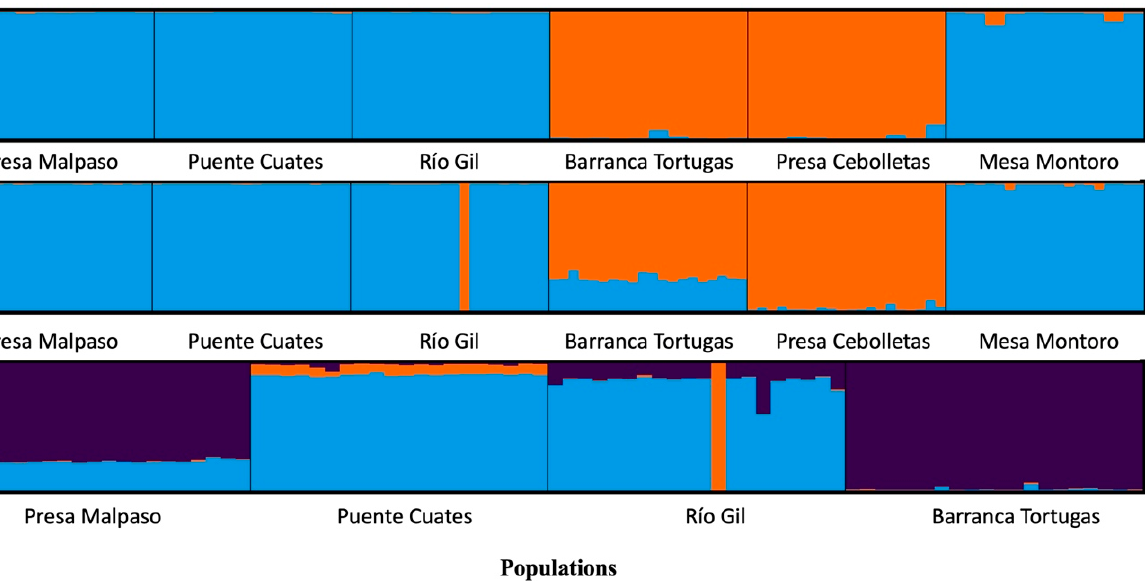
Figure 5. Discriminant analysis of principal components (DAPC) of Pachyphytum caesium without simulation ( a ); with simulation of the extraction of individuals ( b ); and the local extinction of two populations ( c ).